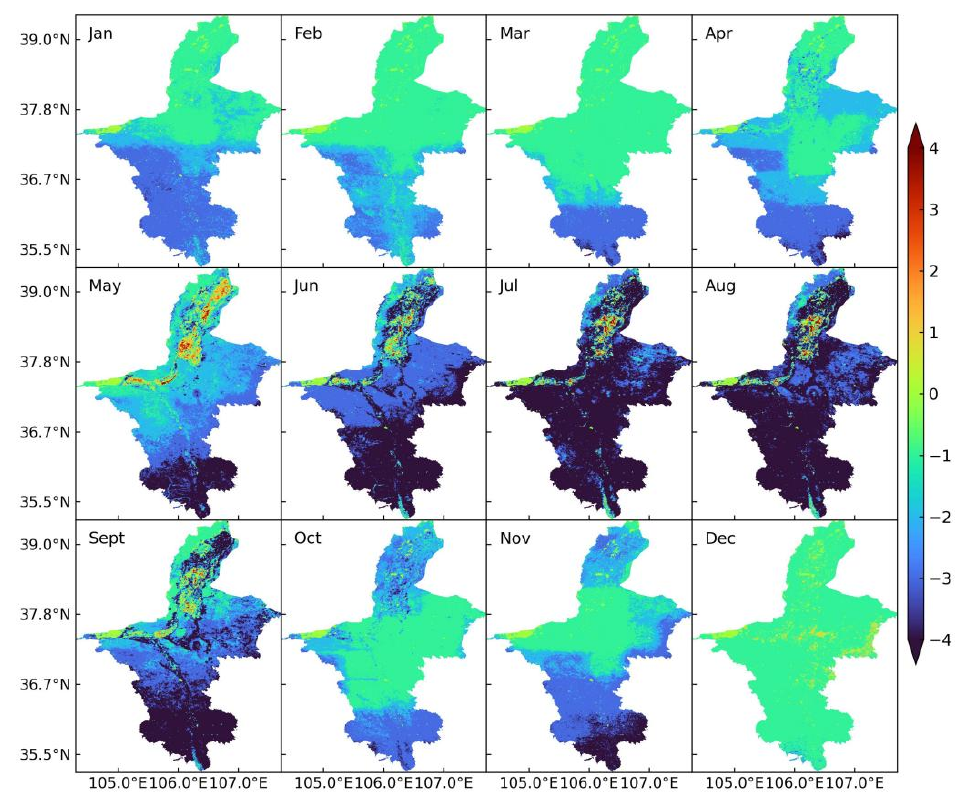
Figure 9. Trends of variation in monthly EDI. (0: no change; − 1: no change; − 2: insignificant decrease; − 3: significant decrease; − 4: extremely significant decrease; 1: insignificant increase; 2: slight increase; 3: significant increase; 4: extremely significant increase).